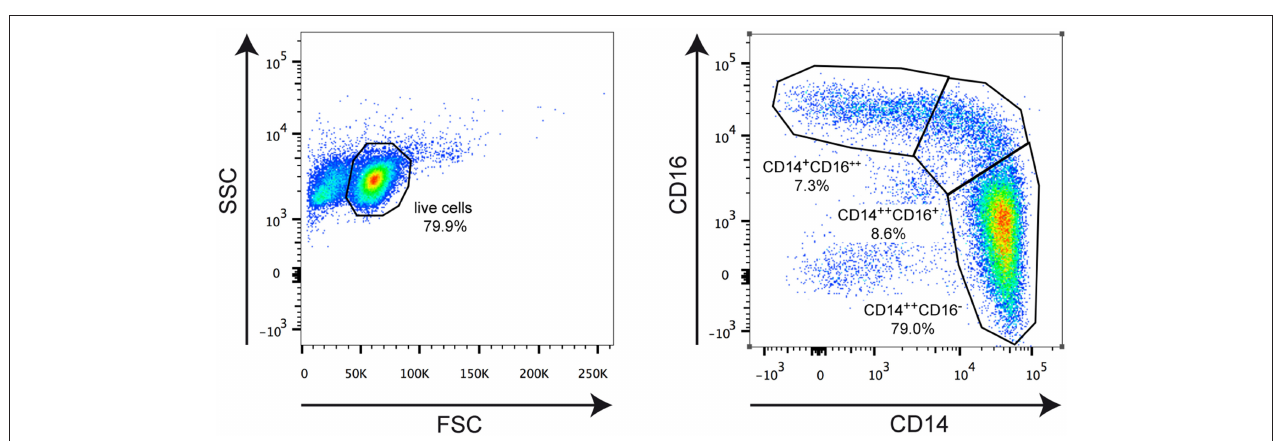
Frontiers in Immunology |